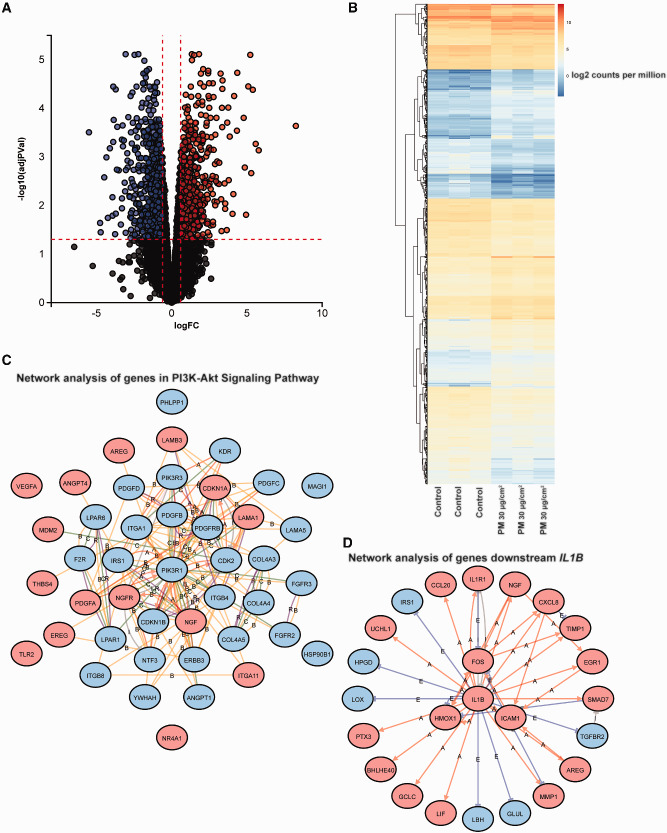
differential expression of genes after 24-h treatment with high-concentration PM2.5. (A) BEAS-2B cells were treated with 30 µg/cm2 of PM2.5 for 24 h before being analyzed by RNA-Seq. The volcano plot demonstrates expression of genes by log fold-change relative to adjusted P-value. (B) Heatmap of 1310 differentially expressed genes between control and treatment with 30 µg/cm2 of PM2.5. (C) Pathway analysis identified enrichment of genes within the PI3K-Akt Signaling Pathway. Shown is the network analysis of genes within this pathway, with red indicating upregulation and blue indicating downregulation after PM2.5 treatment. (D) Pathway analysis also identified IL1B as an upstream hub, with differentially expressed genes downstream of IL1B shown.